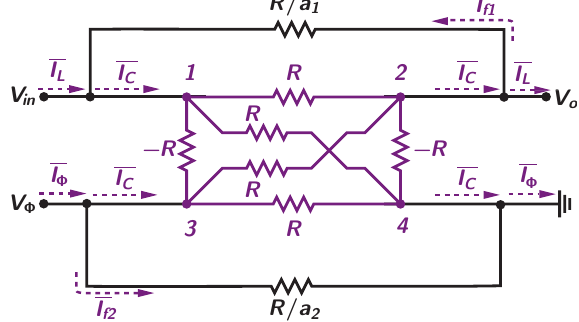
Figure 9. The RN-P model includes the effect of C p 1 and C p 2 .